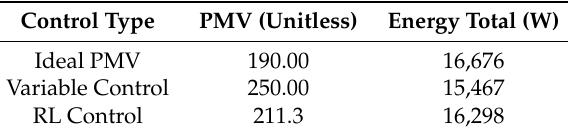
Table 3. Training